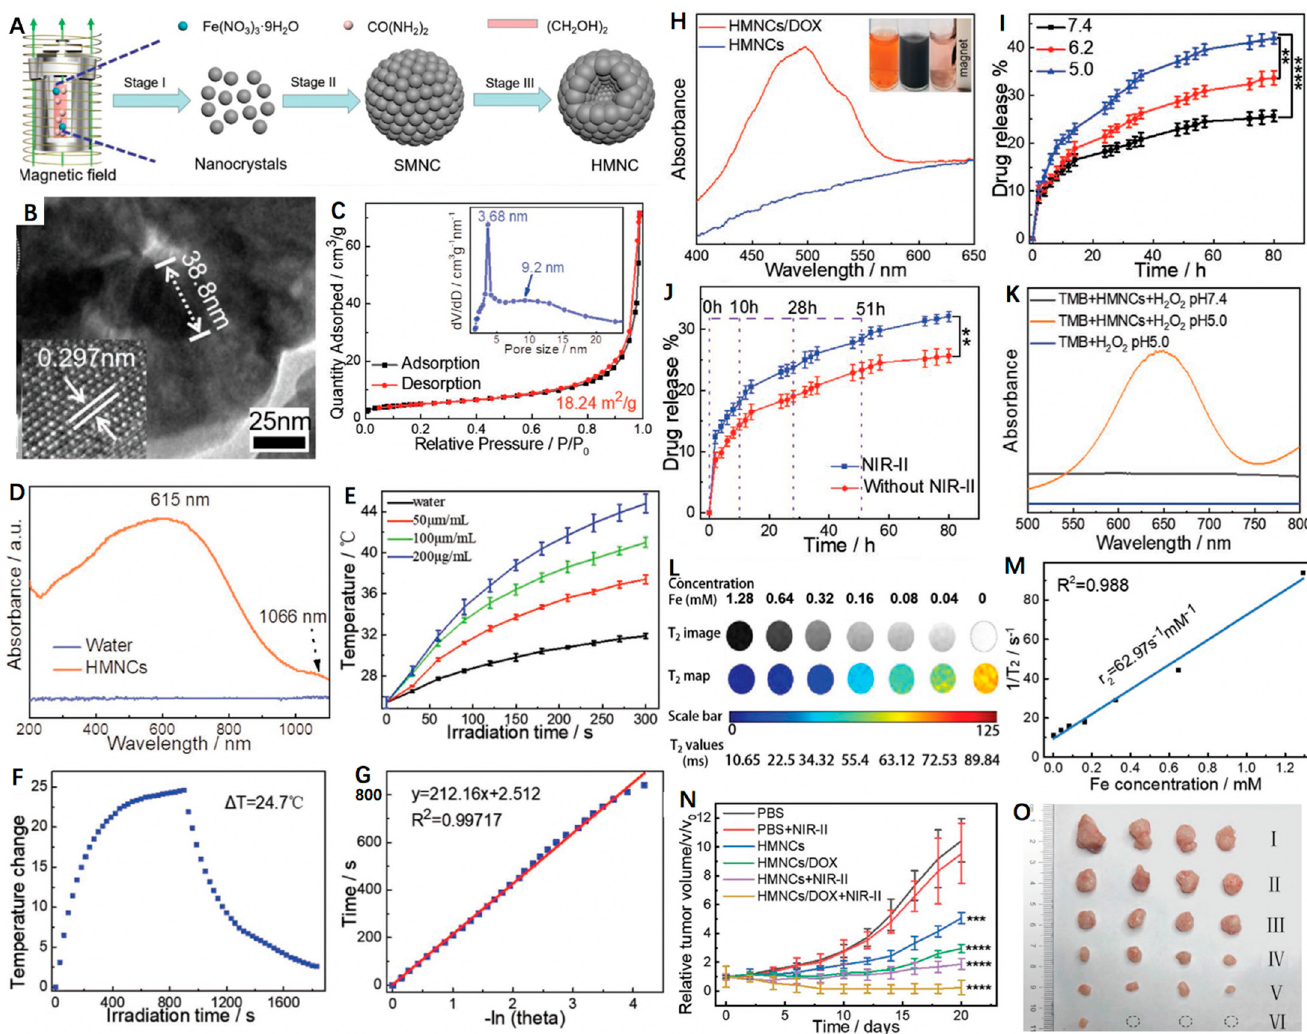
Figure 5. ( A ) Schematic representation of the formation of magnetic-induced HMNCs. (B ) HRTEM image of single HMNCs; the lower lattice of the HMNCs is a single magnetite stripe. ( C ) N 2 adsorption–desorption isotherm of the as-synthesized HMNCs, the inset is the pore size distribution of the HMNCs. ( D ) UV–Vis–NIR absorption spectra of water (control) and the HMNCs aqueous solution. ( E ) Temperature change in pure water (control) and HMNCs solution at different concentrations under NIR-II irradiation (1064 nm, 0.8 W cm − 2 ) for 300 s. ( F ) Temperature change in HMNCs solution (200 μ g mL − 1 ) under NIR-II irradiation time (1064 nm, 0.8 W cm − 2 ); radiation was stopped after 900 s. ( G ) The relationship between the linear time data obtained from the cooling time shown in Figure 4F and -ln θ . ( H ) UV–Vis absorption spectra of the HMNCs and the DOX-loaded HMNCs aqueous solution; the inset: (left) pure DOX solution, (middle) DOX solution mixed with the HMNCs, and (right) the supernatant after magnetic separation. ( I ) Responsive release of DOX from the DOX- loaded HMNCs over time at various pH values (7.4, 6.0, and 5.0) in a 37 °C solution. ( J ) Responsive release of DOX from the DOX-loaded HMNCs with or without NIR-II irradiation over different time points (1064 nm, 0.8 W cm − 2 , 5 min) in PBS solution at pH = 7.4 and 37 °C. ( K ) Vis–NIR absorption spectra of TMB (oxTMB) treated by the HMNCs and H 2 O 2 at different pH values. ( L ) T 2 weighted MR images and quantitative T 2 maps of the HMNCs at different concentrations. ( M ) Plot of 1/ T 2 (R 2 ) as a function of iron concentration in the HMNCs. ( N ) Tumor growth curve of mice treated by different conditions (PBS, I; PBS plus NIR-II, II; HMNCs, III; DOX-loaded HMNCs, IV; HMNCs plus NIR-II, V; DOX-loaded HMNCs plus NIR-II, VI). ( O ) Typical photos of the tumors collected from mice with different treatments at the end of the treatment (day 20). Reprinted with permission from Ref. [106]. Copyright 2021, Wiley-VCH GmbH. ** p < 0.01, *** p < 0.001, **** p < 0.0001.